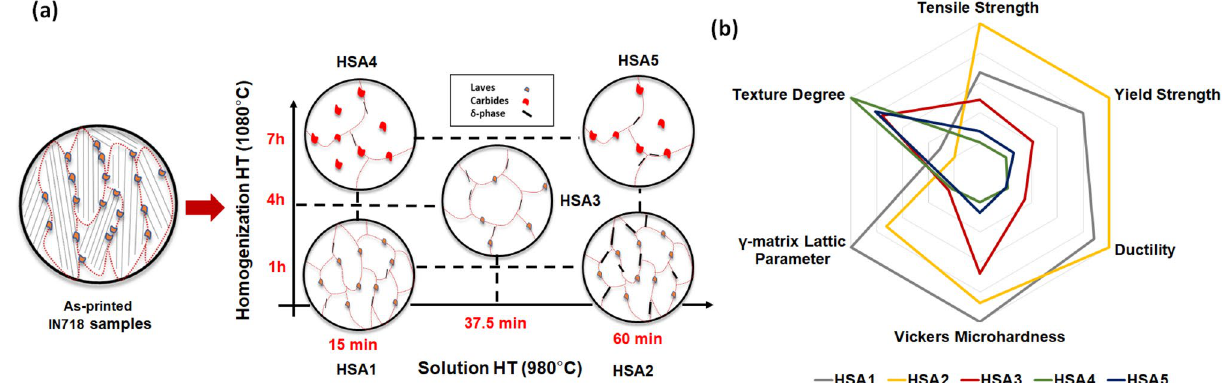
Figure 13. ( a ) Thermal post-processing map of LPBF IN718 alloy displaying the microstructure, phases and grain morphologies as functions of the heat treatment times; ( b ) radar chart summarizing the effect of the heat treatment time window on the texture, γ-matrix lattice parameter and mechanical